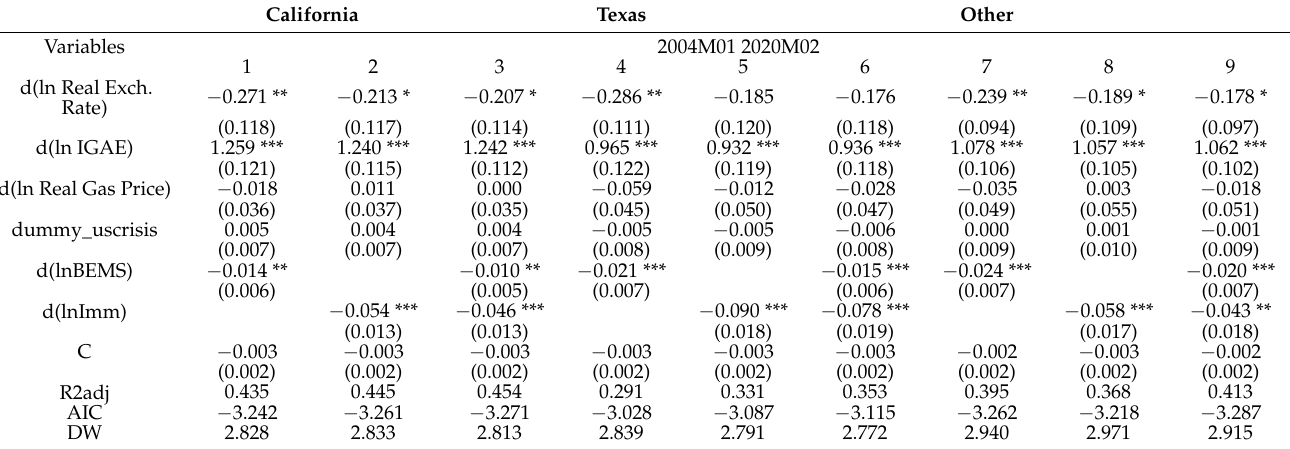
Table 6. OLS regressions results of personal vehicle crossings clustered by regions